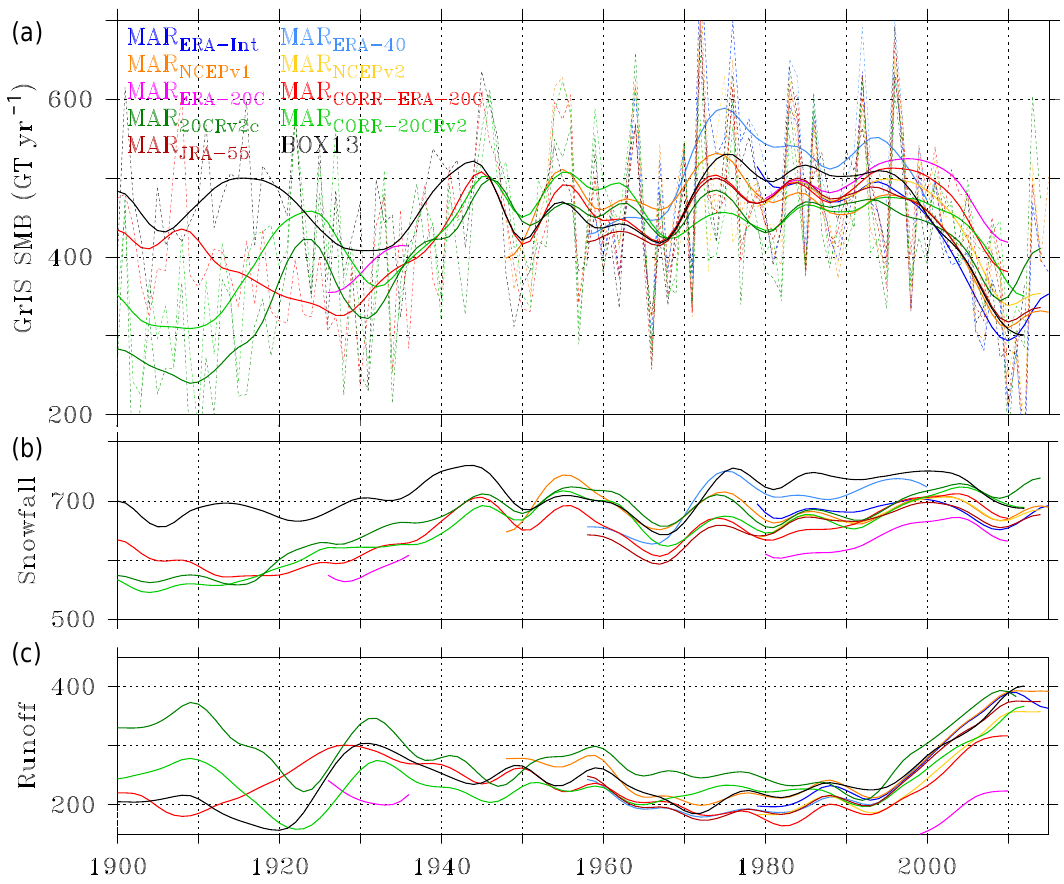
Figure 8. (a) Time series of the annual SMB (in GTyr − 1 ) integrated over the whole ice sheet as simulated by MAR using the different listed forcings and coming from Box’s reconstruction (BOX13). (b) Same as (a) but for snowfall. (c) Same as (a) but for run-off. Finally, only 10-year running means are shown for both (b) and (c) for more readability.